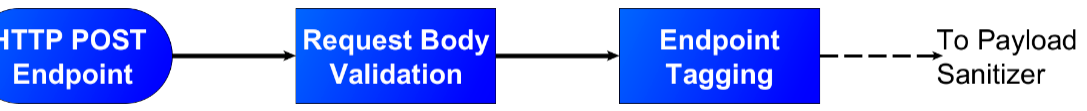
Figure A2. HTTP POST endpoint service-based data ingest step for device data integration.